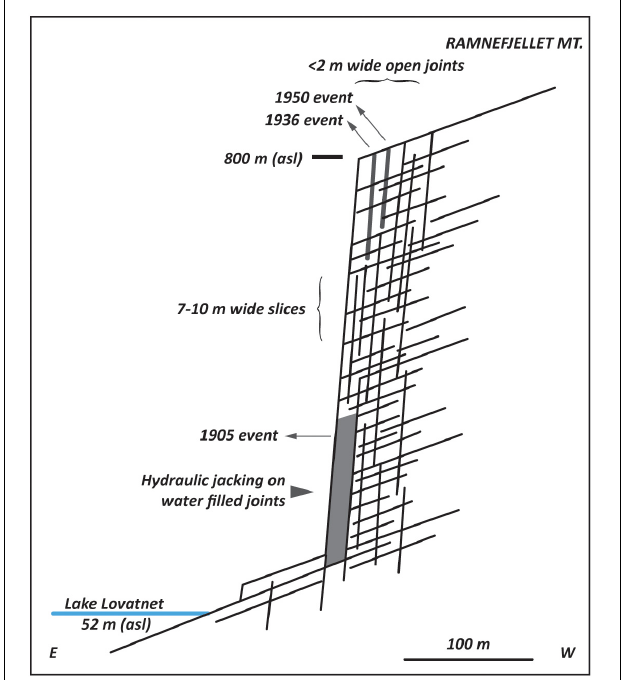
FIGURE 4 | Simplified cross-section across Mt. Ramnefjellet in a W-E direction, describing the general inherited fracture patterns and development of associated series of rock fall events [figure modified from Grimstad